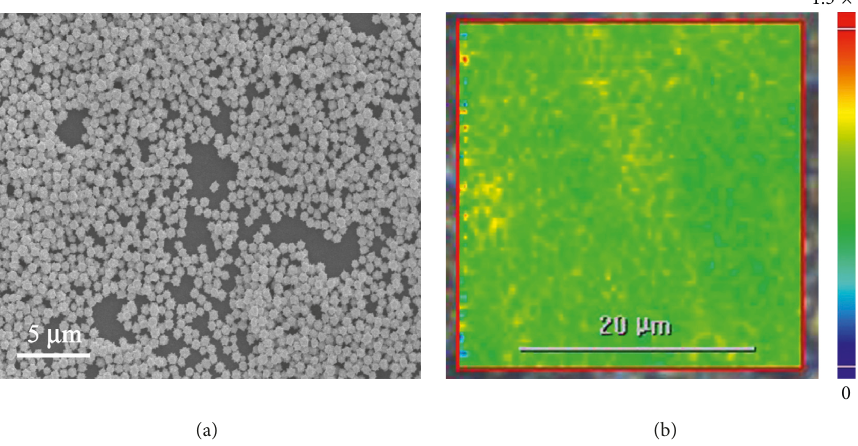
1 using the HGNP substrate. The −